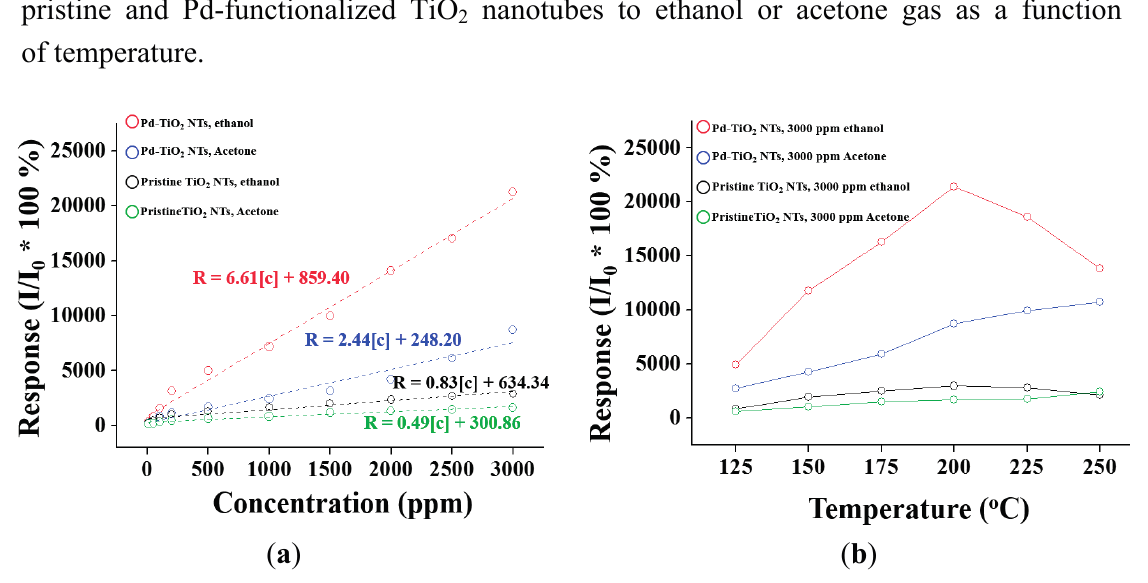
nanotubes to ethanol or acetone gas as a function 2